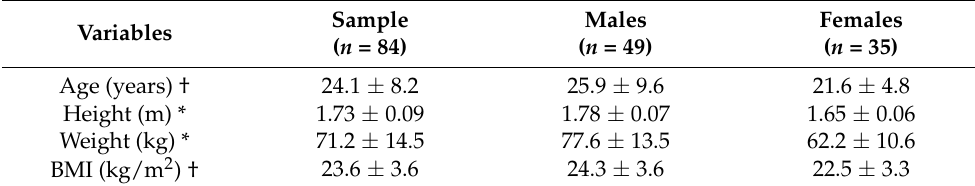
Table 1. Participants’ baseline demographic characteristics. Variables